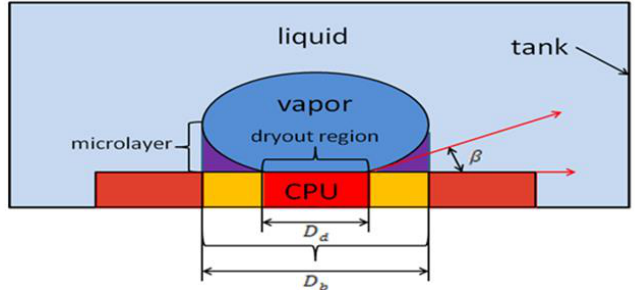
wall and t gr is the growth time from the beginning of the bubble growth to when it leaves the wall.